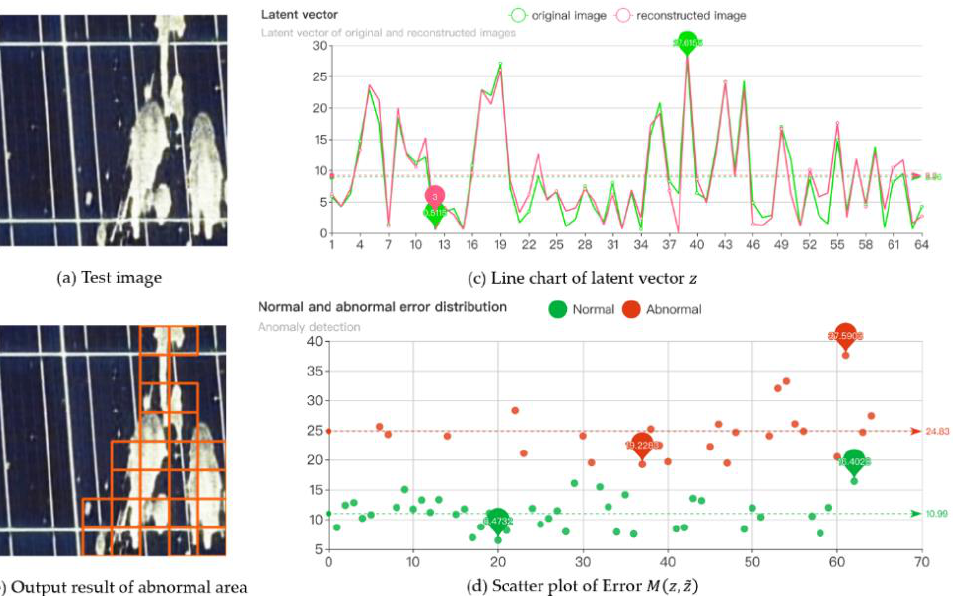
Figure 14. Output results of abnormal detection. ( a ) Test image; ( b ) Output result of abnormal area; ( c ) Line chart of latent vector 𝑧 ; ( d ) Scatter plot of Error 𝑀(𝑧, 𝑧̃) .